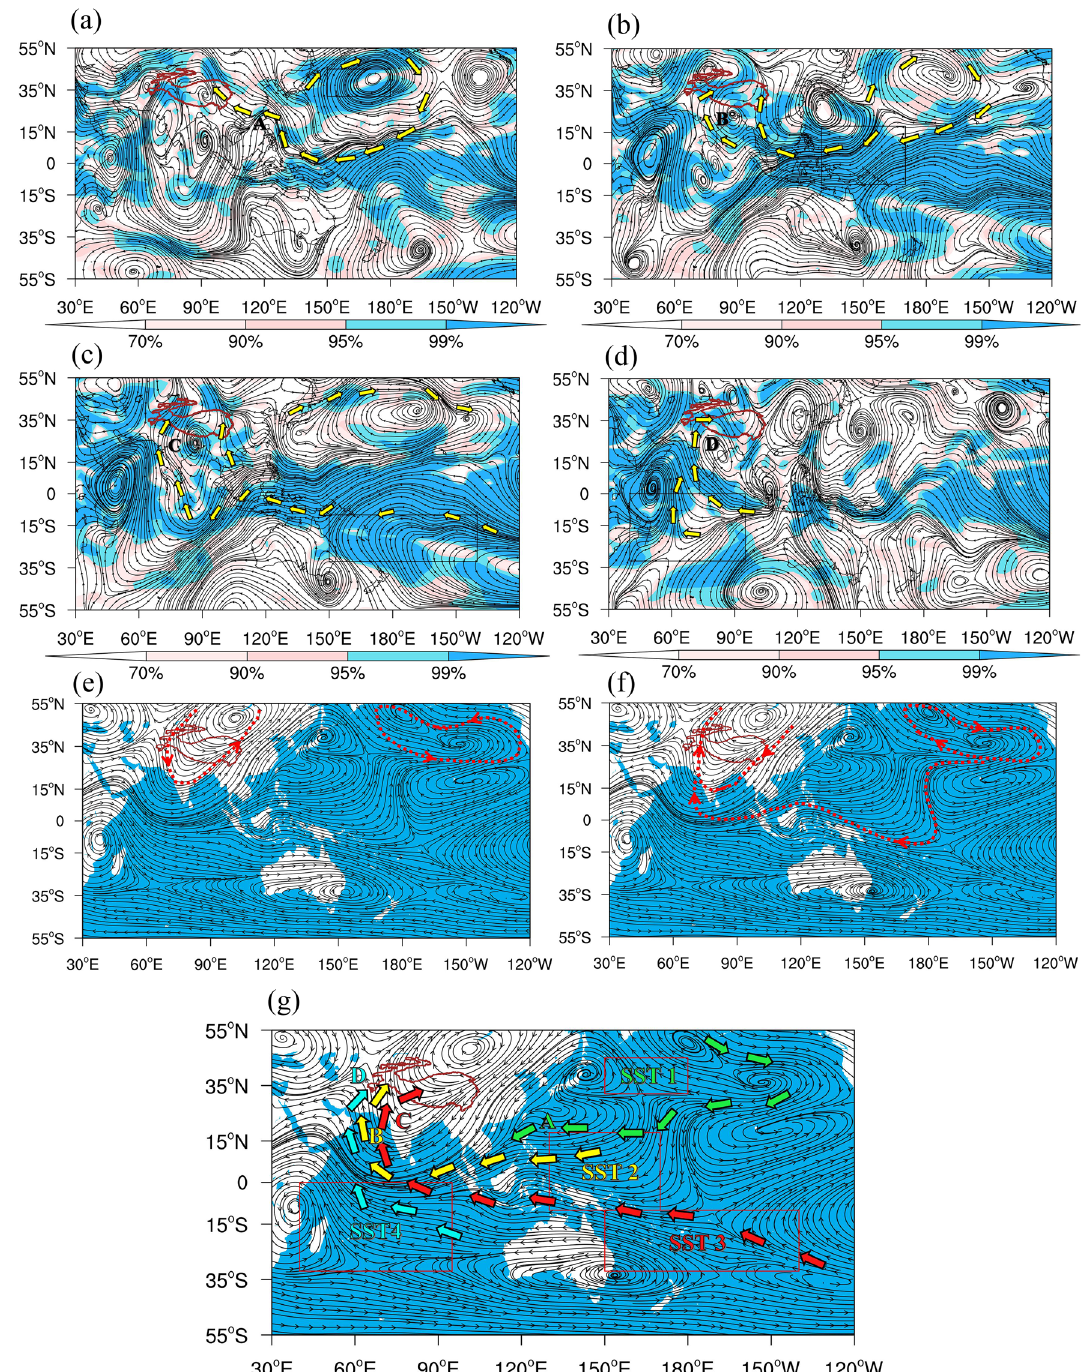
Figure 3. Distribution of correlation between standardized SST and surface-300 hPa water vapor flux in summer from 1991 to 2020. ( a ) SST area 1, ( b ) SST area 2, ( c ) SST area 3 and ( d ) SST area 4. Anomaly field of the whole-layer water vapor fluxes ( e ) for 1961–1990 and ( f ) for 1991–2020. ( g ) Comprehensive effect image of the water vapor transport structures in the four high-impact areas on the warming-wetting of QTP. The maps were generated with NCAR Command Language (NCL) Version 6.2.1 (http:// www. ncl. ucar.